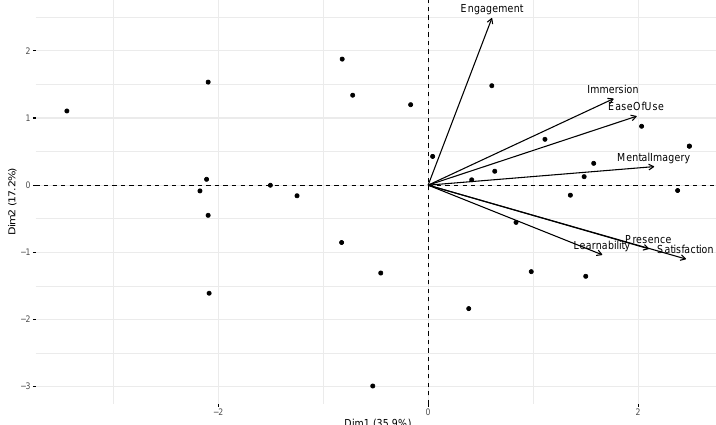
Figure 8. Variable correlation plot for the user experience factors. Figure 9 depicts a scree plot, which is the plot of eigenvalues ordered from largest to the smallest. The optimal number of components to be chosen for the PCA corresponds to the point beyond which the remaining eigenvalues are relatively small and of comparable size.